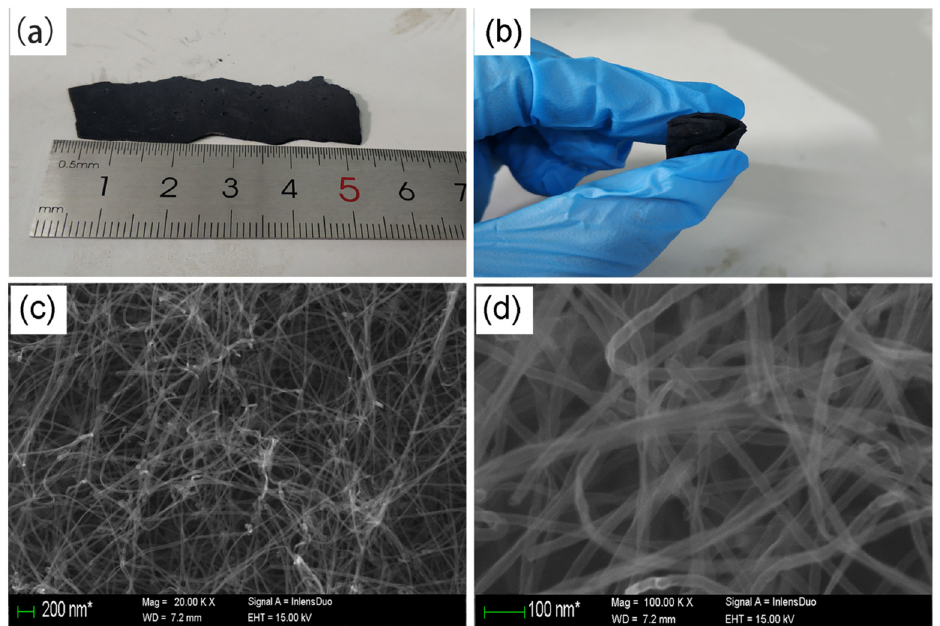
Figure 2: ( a ) and ( b ) Prepared MWCNT sponge; ( c ) and ( d ) low - resolution and high - resolution SEM image showing the random CNT network of sponges.